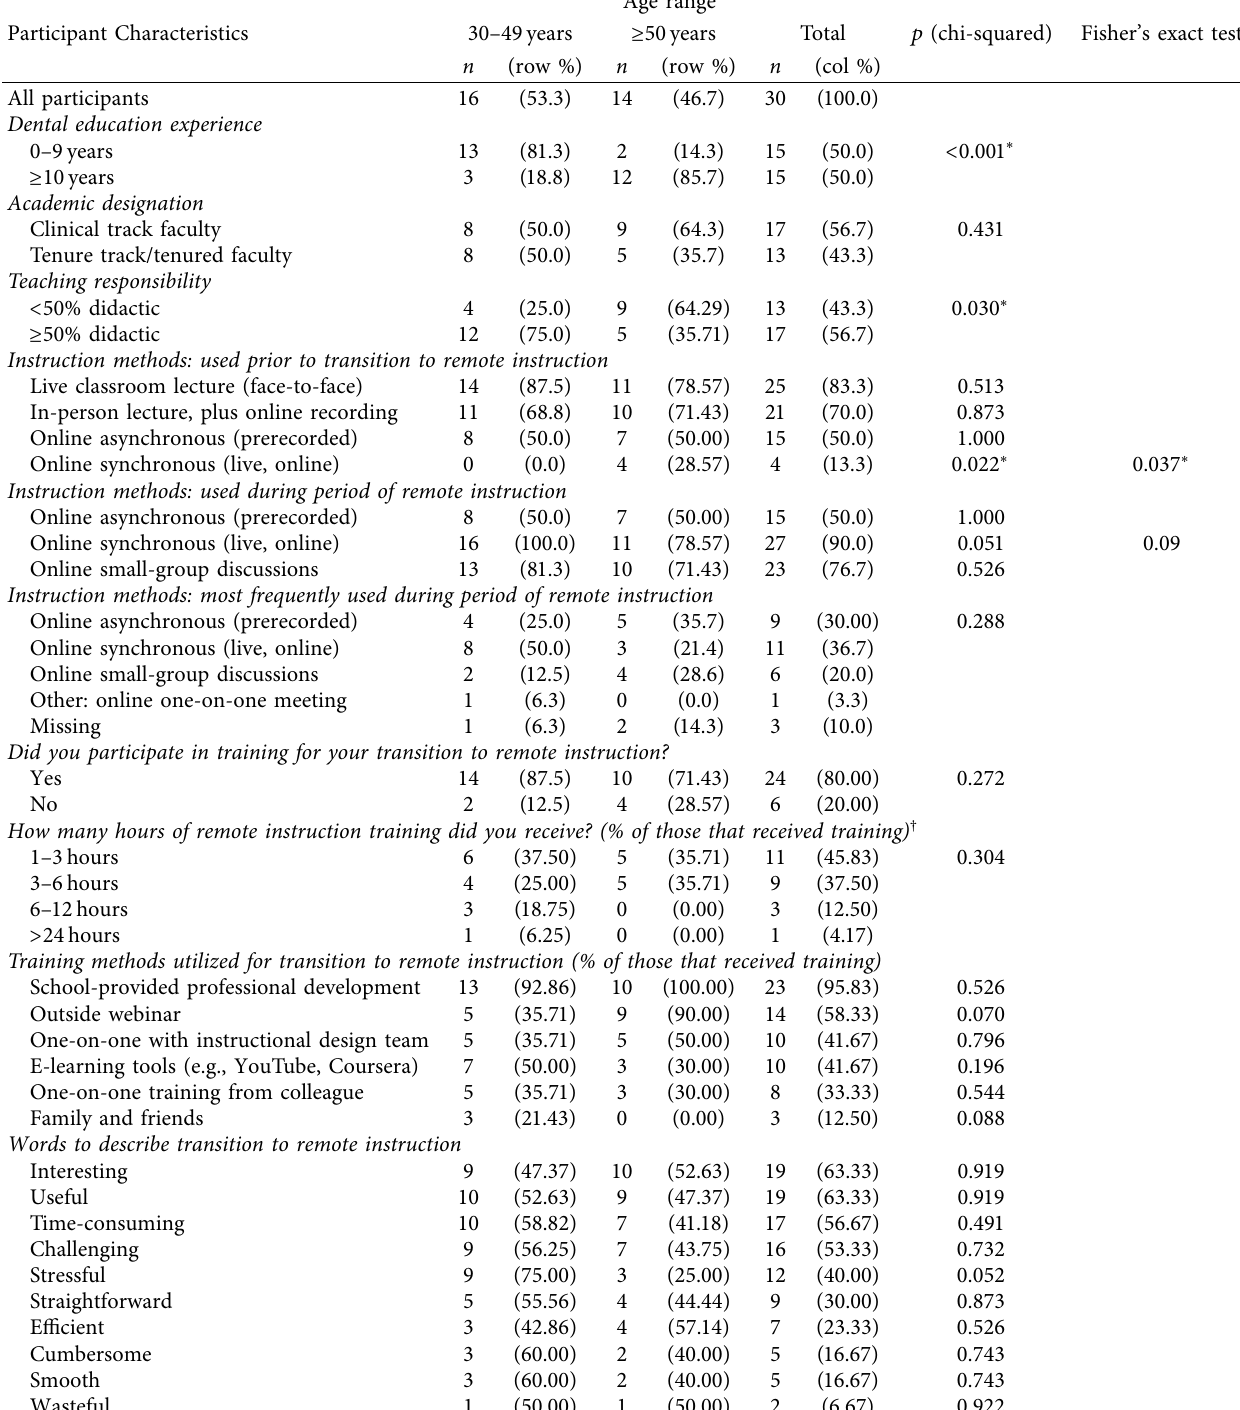
Table 1: Experience in dental education, academic designation, and self-reported teaching responsibility distribution of Detroit Mercy dental faculty participants that made the transition to complete remote instruction in March 2020 and their experience with different instruction methods prior to and during the shift, experience with training, and words to describe their transition to remote